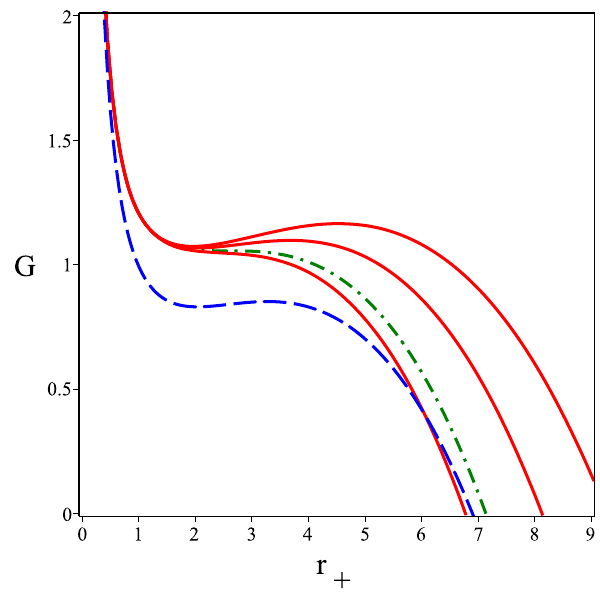
Fig. 3 The behavior of G for our solution in terms of r + for P = 0 . 003 , 0 . 002669 , 0 . 002 , 0 . 0015 (left to right) and Q = 1, and for RN- AdS metric (dashed line) for P = 0 . 002669, Q =